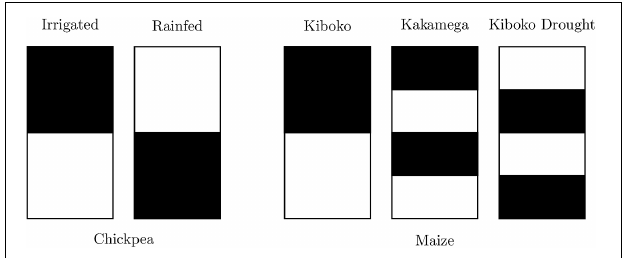
FIGURE 1 | Representation of sparse prediction scheme in maize and chickpea. Black represents records present in the model fit for individuals in each environment, while white represents removed (i.e., missing)